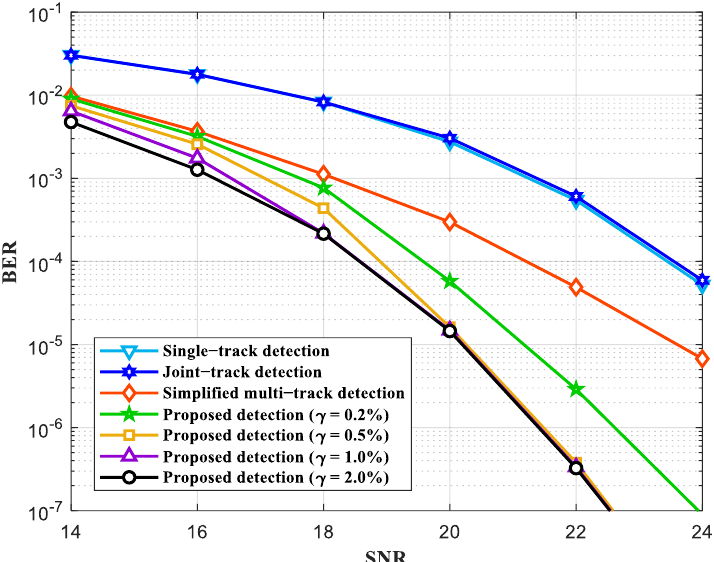
Figure 3. BER performances for the various detection schemes with 0% TMR when an areal density is 3.0 Tb/in 2 .